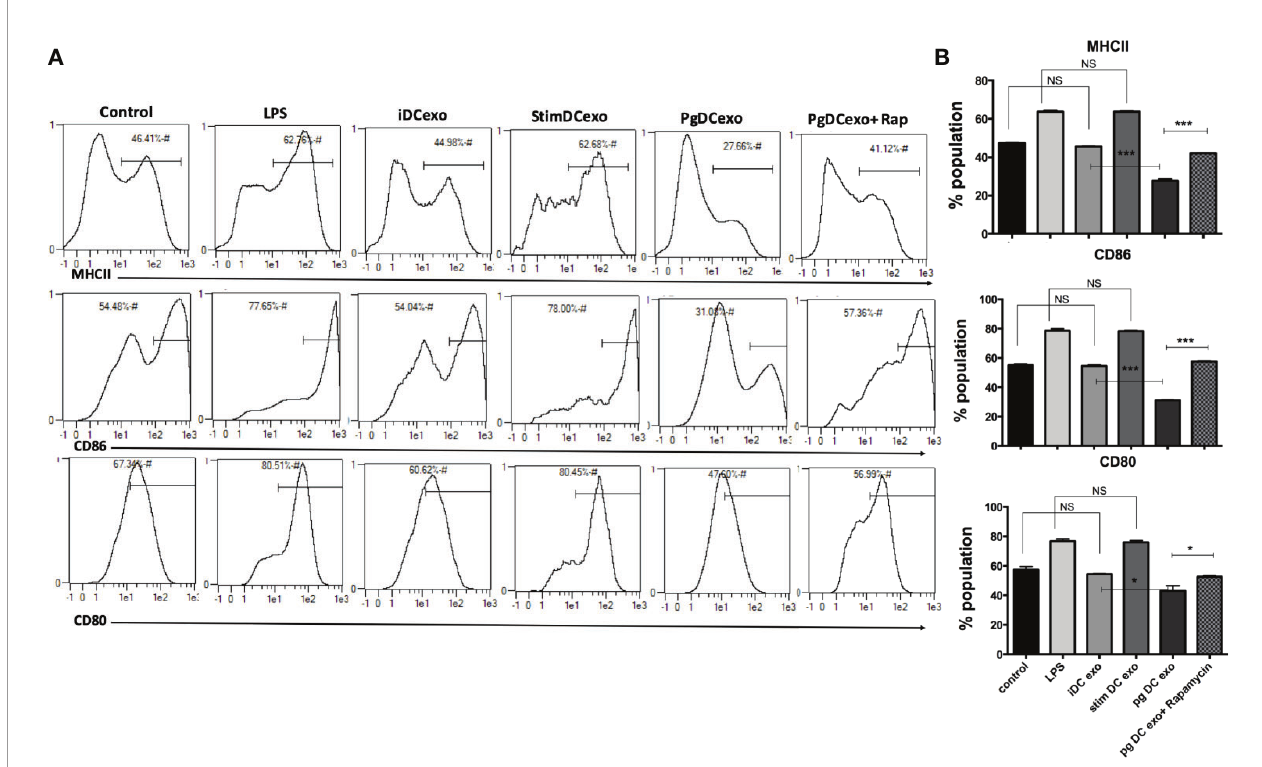
FIGURE 6 | PgDCexo impairs maturation of recipient yDCs: At day 6, yDCs were treated with PgDCexo ± Rapamycin, StimDCexo, iDCexo, Dox, E-coli LPS or received no treatment (Con) and incubated for 48 hrs. Cells were harvested at day 8 and analyzed by fl ow cytometry for the expression of maturation markers MHCII and co stimulatory molecules CD80 and CD86. (A) Representative fl ow cytometry histograms showing % of MHCII + population in yDCs (upper panel) %CD86 + (middle panel) and %CD80+ (lower panel) gated on CD11c + cells (gate not shown). (B) Summary bar graphs for fl ow cytometry data shown in (A) . Analysis was done using one-way ANOVA and Tukey multiple comparison post hoc test (Data are expressed as means ± SD, *p<0.05, ***p<0.001). (iDCs), control immature DCs exo; (StimDCexo), Ecoli LPS-stimulated mature DCs exo; (PgDCexo) Pg-infected DCs. NS, not signi fi